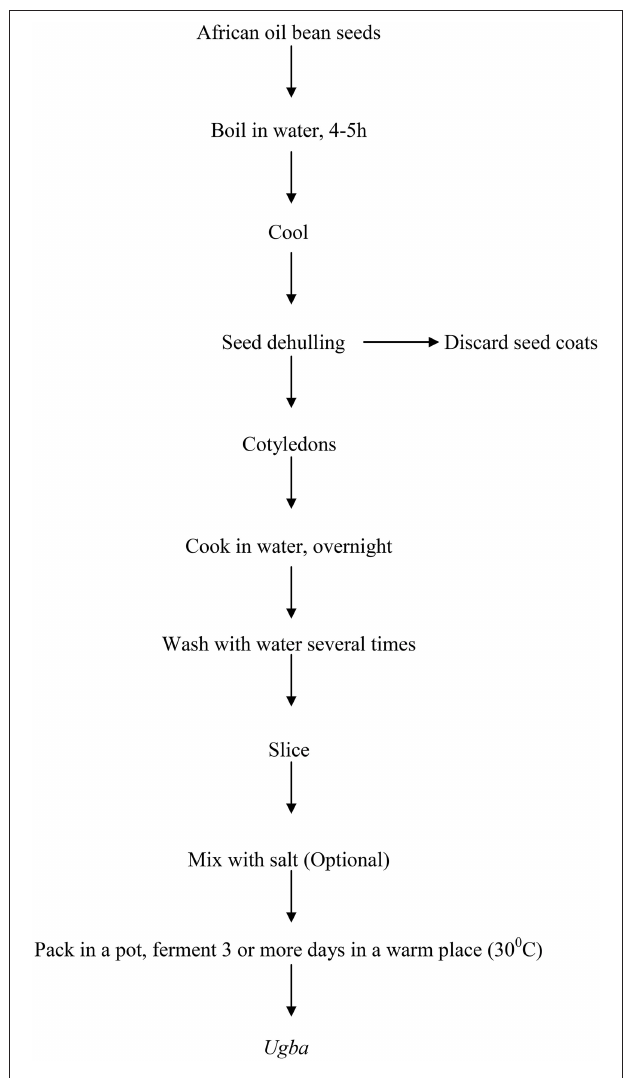
FIGURE 2 | Flow chart for the preparation of ugba (Odunfa and Oyeyiola, 1985 ).